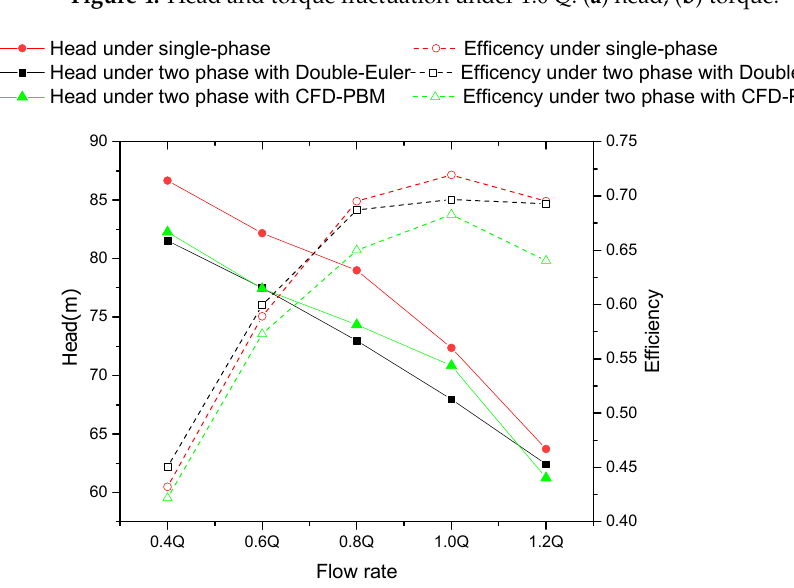
Figure 5. Hydraulic performance curves of single-phase and gas–liquid two-phase.